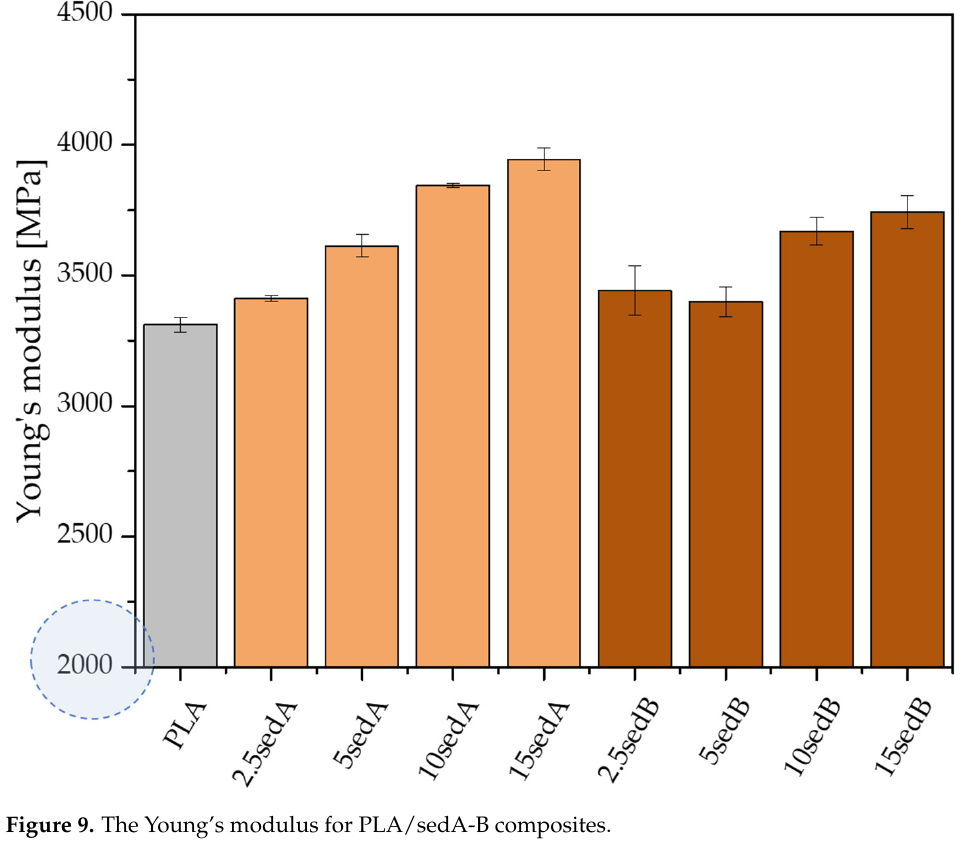
Figure 9. The Young’s modulus for PLA/sedA-B composites.